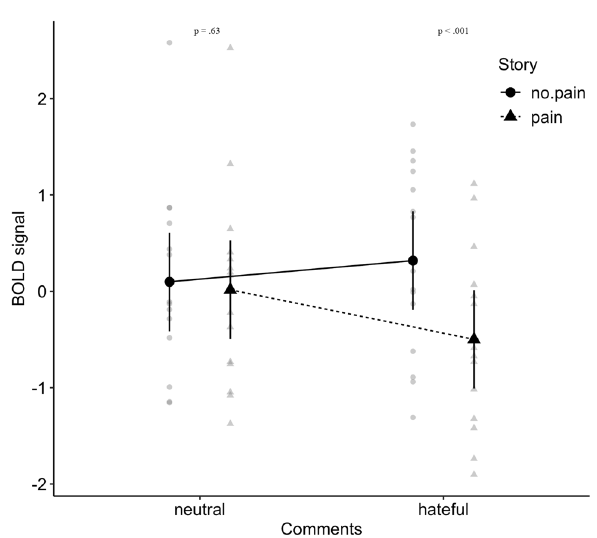
Figure 6. Type of Comments (Neutral vs. Hateful) × Story (No Pain vs. Pain) Interaction Observed in the Right TPJ. Black points indicate estimated means. Gray points indicate individual observations. Vertical lines indicate 95% confidence